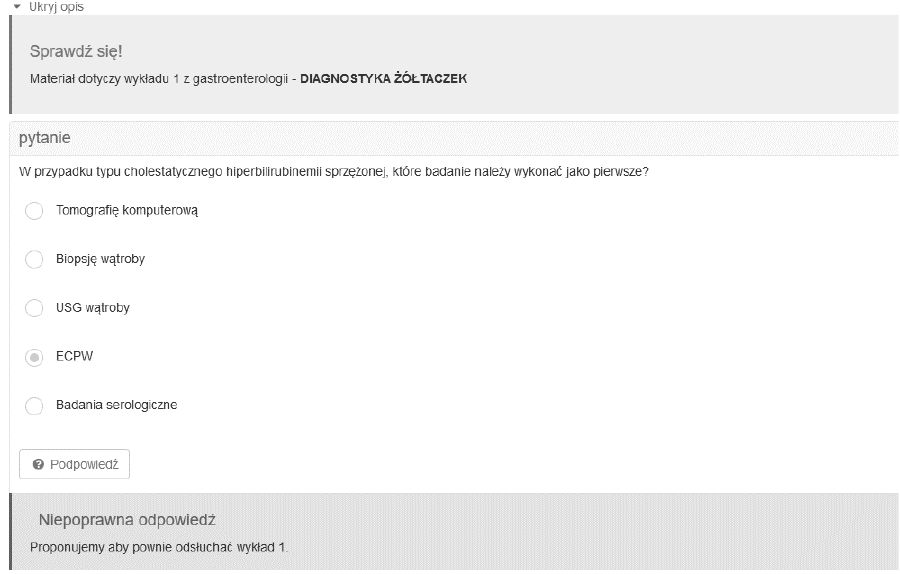
Figure 5. Self-test question as a follow-up to an e-learning lecture in Gastro- enterology for year 5 students of Medicine, with an example reaction to a wrong